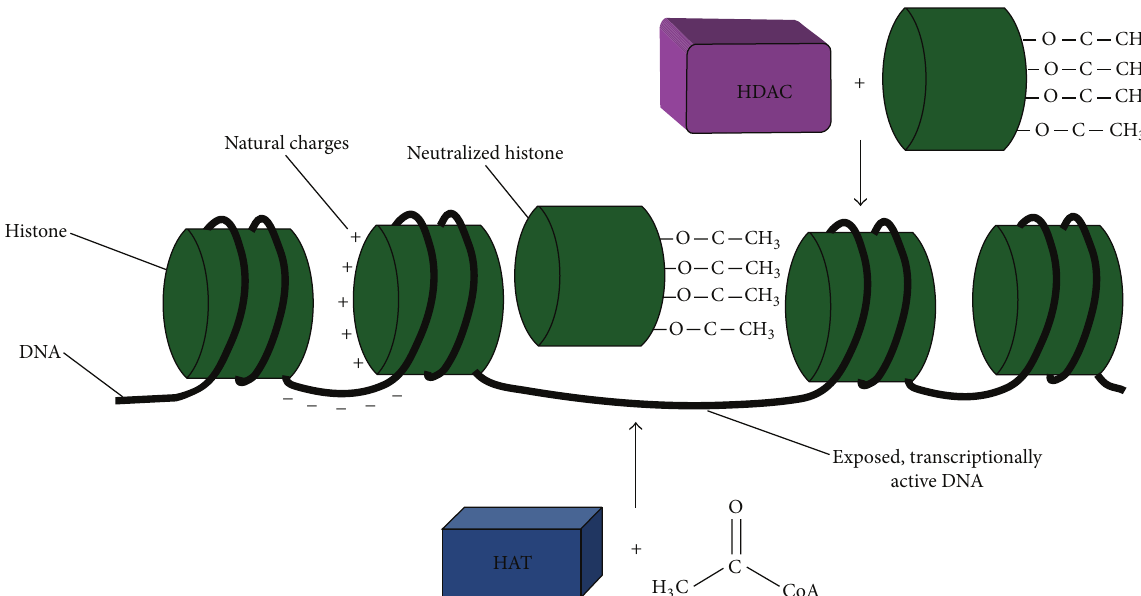
Figure 1: Histone regulation of gene expression. Positively charged histone octamers bind to the negatively charged phosphate backbone of DNA, condensing it into transcriptionally inactive heterochromatin. Histone acetyltransferase (HAT) enzymes donate acetyl groups from acetyl-coenzyme A to histone proteins, thereby neutralizing its positive charge, resulting in its dissociation from DNA, making it transcriptionally active. This relaxed form of chromatin, euchromatin, can then reassociate with DNA through the action of histone deacetylases (HDACs), which remove acetyl groups from the neutralized histone protein, returning it to transcriptionally inactive cationic